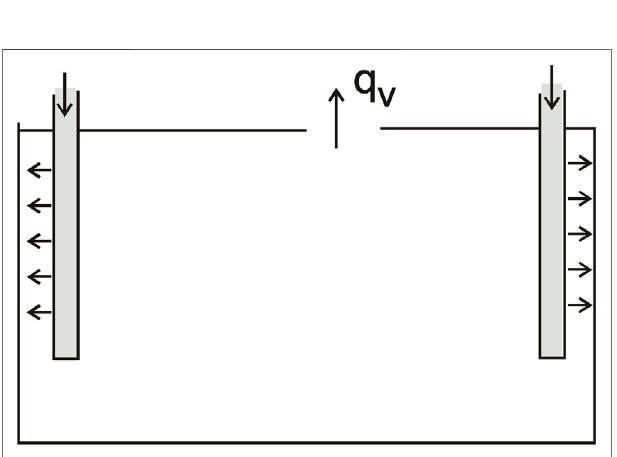
FIGURE 12 | Modern version of supply thorough a bundle of nozzles (con fl uent